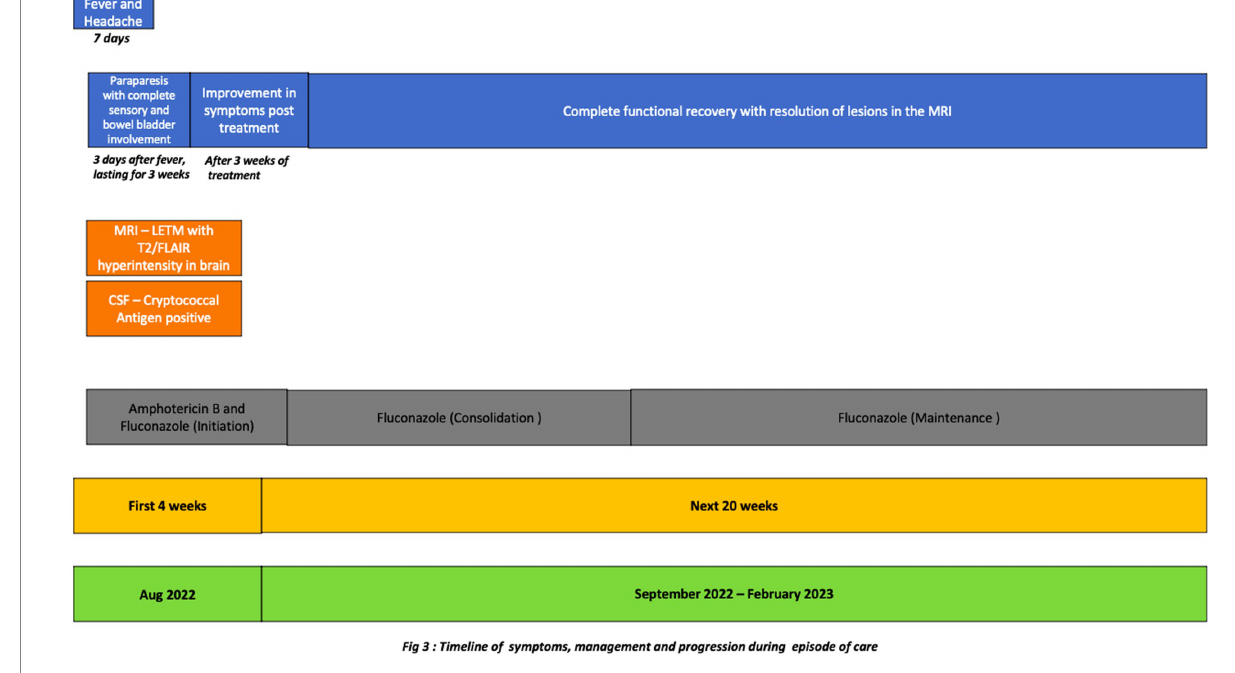
FIGURE 3 Timeline of symptoms, management and progression during episode of